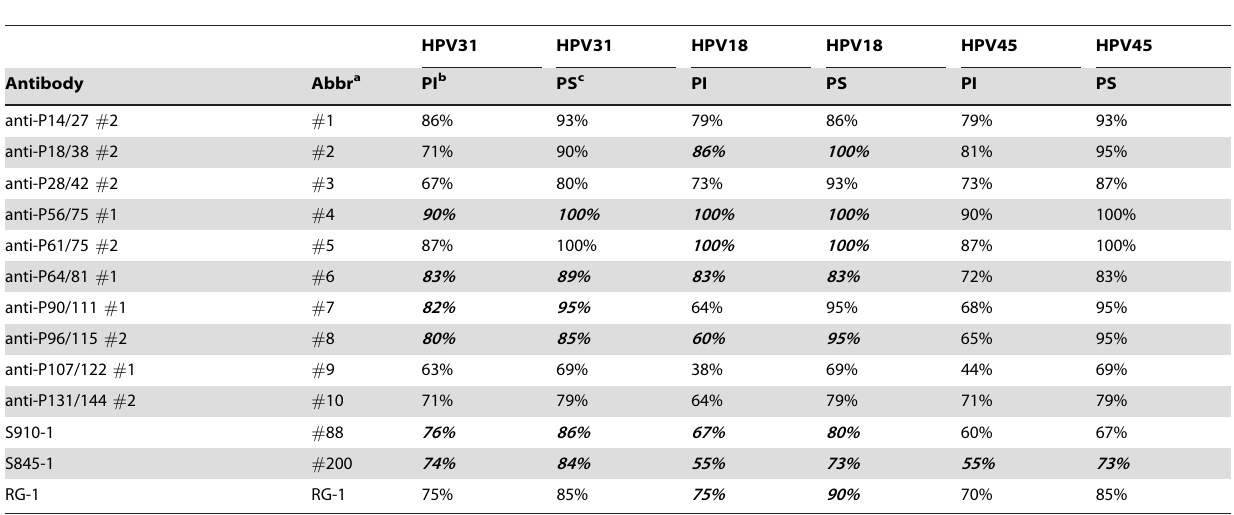
Table 1. Percent identities and similarities of HPV31, HPV18, and HPV45 L2 epitopes compared to HPV16 L2 epitopes.